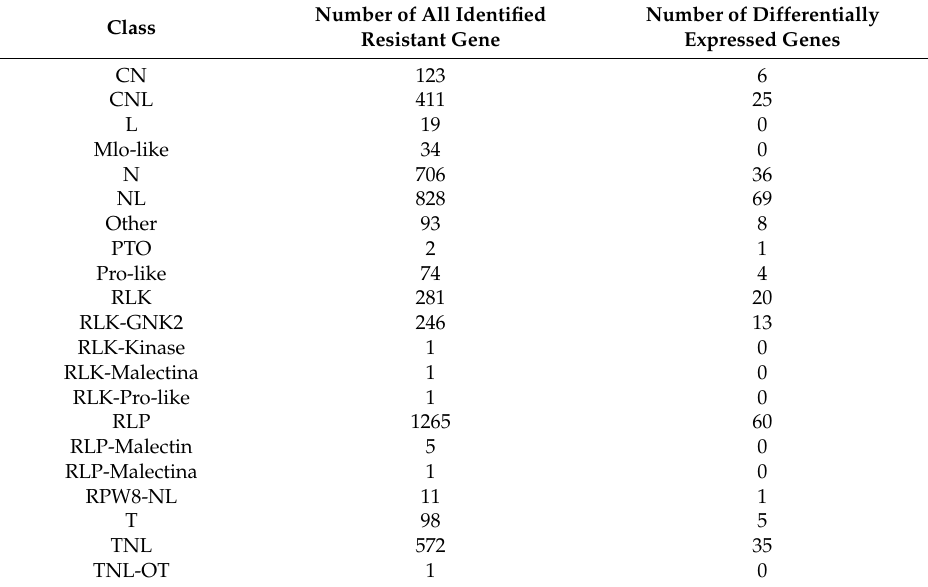
Table 5. The differentially expressed resistant